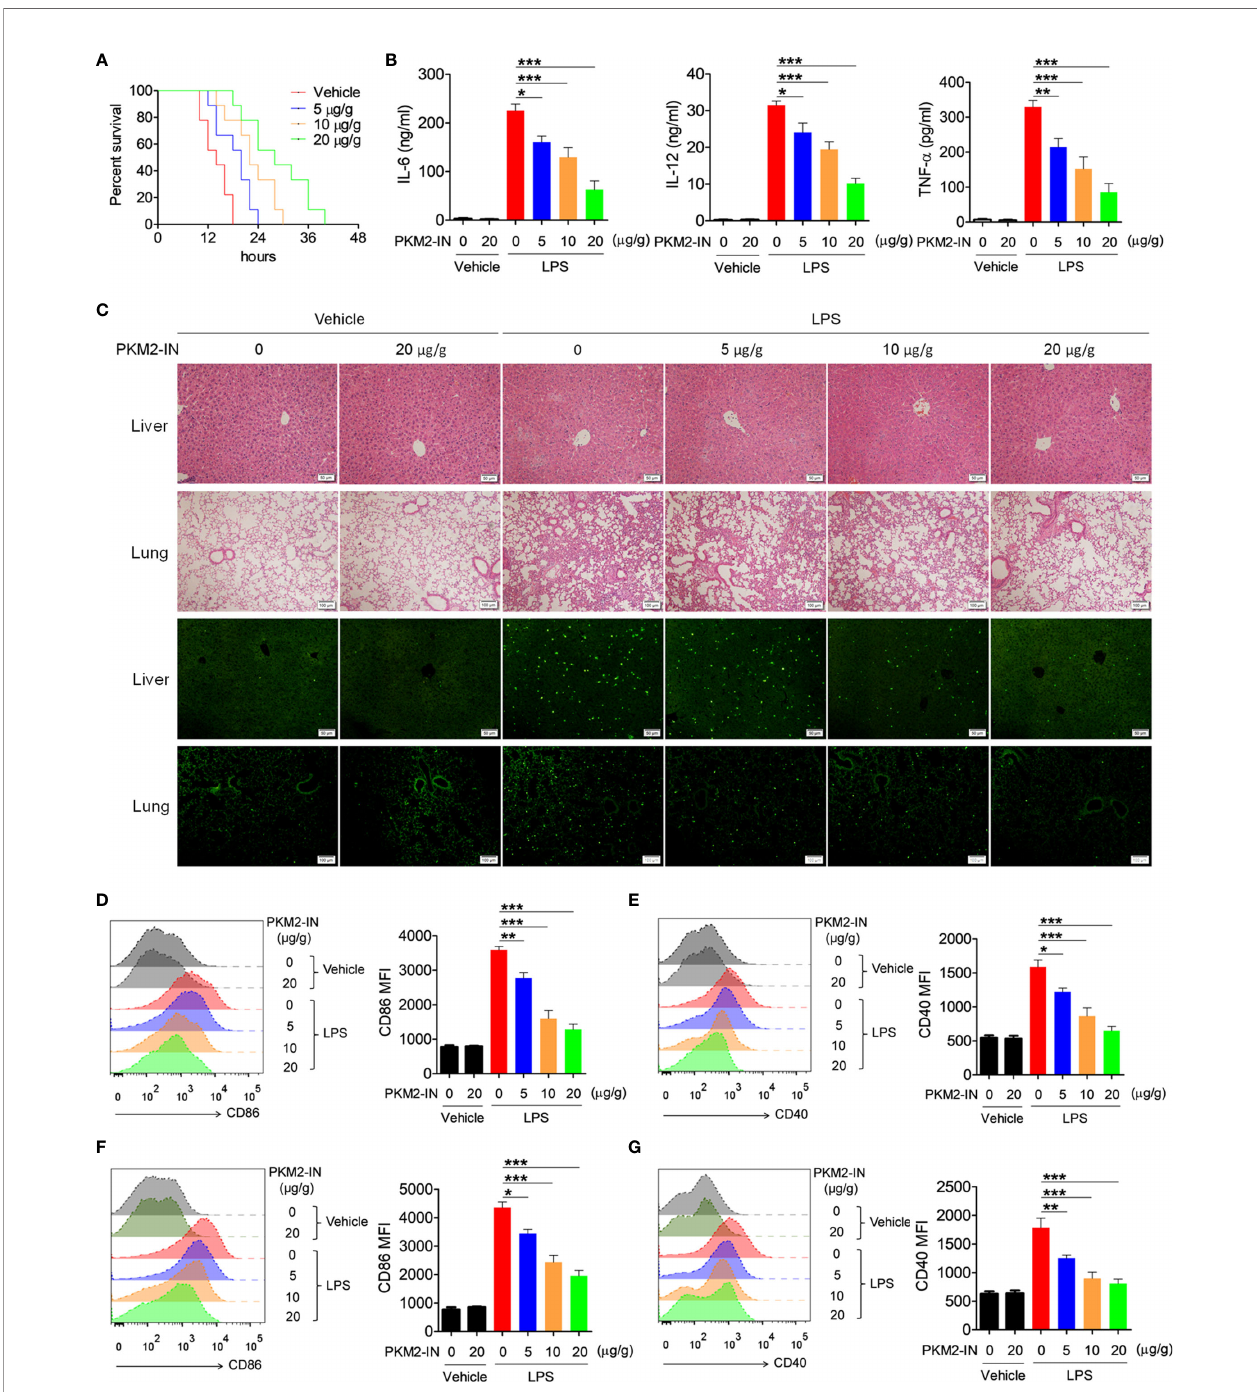
FIGURE 6 | Pharmaceutical inhibition of PKM2 relieves LPS-induced endotoxin shock. (A) C57BL/6 mice were intraperitoneally injected with PKM2-IN (5, 10, 20 m g/ g body weight) or vehicle for 2 hours followed by LPS challenge (37.5 m g/g body weight) and the mortalities of mice were observed (n=9 mice/group). (B – G) C57BL/ 6 mice were intraperitoneally injected with PKM2-IN (5, 10, 20 m g/g body weight) or vehicle for 2 hours followed by LPS challenge (10 m g/g body weight). Levels of IL-6, IL-12 and TNF- a in serum were determined by ELISA after 3 hours (B). Lung and liver sections were stained with H&E and apoptosis in the cells of lung and liver was analyzed by TUNEL (C) . FACS analysis was performed to assess the expressions of CD86 and CD40 on surface of splenic F4/80 + macrophages (D, E) and CD11c + DCs (F, G) after 12 hours. The data are shown as the means ± SEM (n=6 mice/group) and are representative of three independent experiments. * p < 0.05, ** p < 0.01, *** p < 0.001, as determined by ANOVA